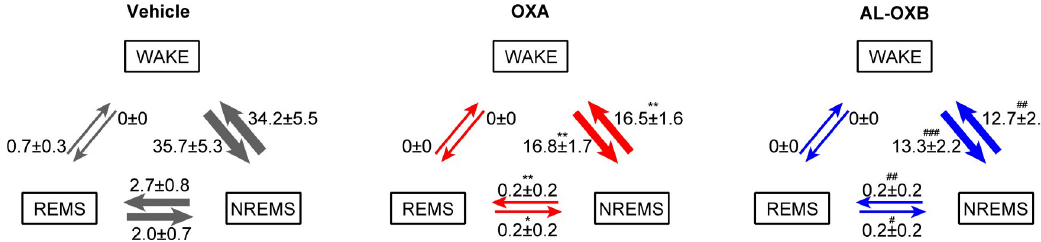
Fig 3. ICV AL-OXB prevents sleep/wake fragmentation in OXKO mice. The number of transitions between sleep/wake stages over 3 h after ICV administration of vehicle (left), 3 nmol OXA (middle), and 3 nmol AL-OXB (right) at ZT11-12. Data represent the means ± SEM from 6 mice. � p < 0.05, �� p < 0.01, ���� p < 0.0001 for OXA vs. vehicle; #p < 0.05, ##p < 0.01, ####p < 0.0001 for AL-OXB vs. vehicle; one-way ANOVA followed by Bonferroni’s multiple comparisons